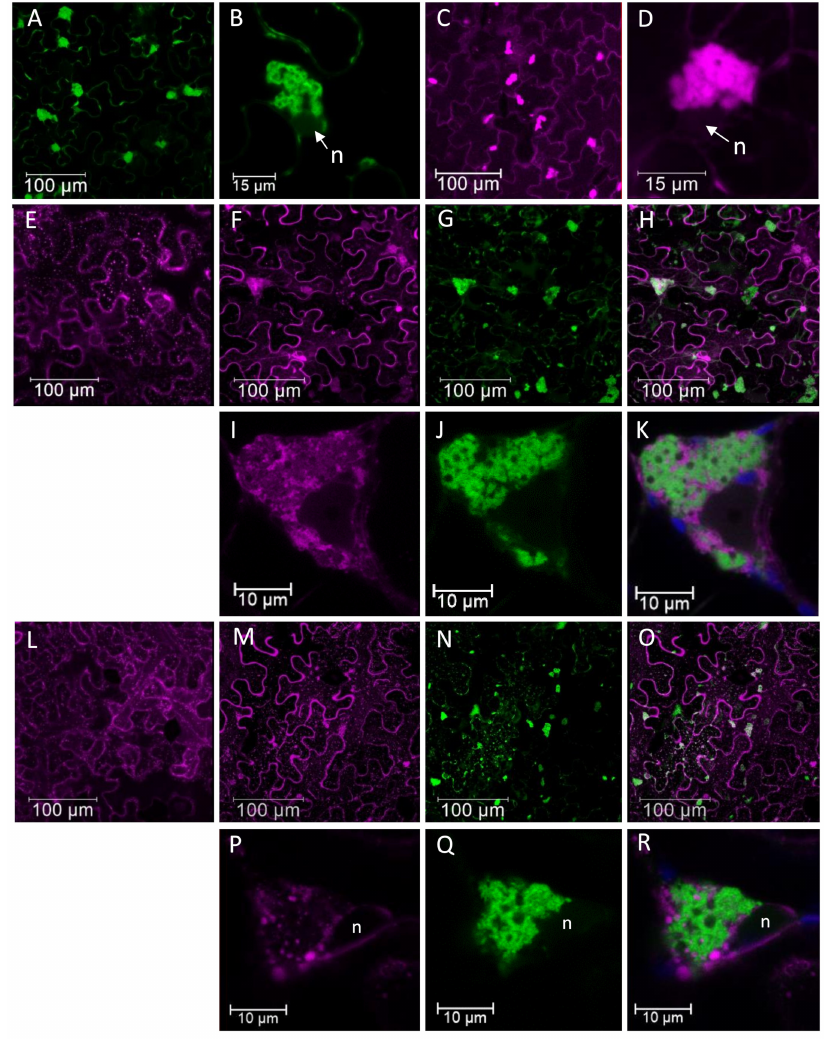
Figure 6. Pepino mosaic virus (PepMV)-induced subcellular bodies in Nicotiana benthamiana and tomato plants. ( A ) and ( B ) confocal laser scanning microscopy (CLSM) images of PepGFPm2 infection in N. benthamiana at 3 days post-inoculation (dpi). ( B ) High magnification of a fluorescent body in PepGFPm2 infection to show its cytoplasmic localization and spatial relation with the nucleus. ( C ) and ( D ) CLSM images of PepDsRed infection in tomato at 3 dpi. ( D ) High magnification image of a fluorescent body in PepDsRed infection. ( E ) Distribution of the endoplasmic reticulum marker (ER- mCherry) at 3 dpi in N. benthamiana epidermal cells in the absence of PepMV infection. In the presence of PepGFPm2 infection: ( F ) changes of ER-mCherry localization were observed, ( G ) green fluorescent bodies of PepGFPm2 and ( H ) merged image of ( F ) and ( G ) to see the matching. High magnification images: ( I ) the distribution of ER-mCherry during the infection, ( J ) the PepMV subcellular body and ( K ) merging of ( I ) and ( J ) to show the incomplete matching between the red and the green labelling in the body. ( L ) Distribution of Golgi-mCherry marker at 3 dpi in N. benthamiana epidermal cells in the absence of PepMV infection. In the presence of PepGFPm2 infection: ( M ) changes of Golgi-mCherry localization were observed ( N ), green fluorescent bodies of PepGFPm2 and ( O ) merged image of ( M ) and ( N ) to show the matching. High magnification images: ( P ) the distribution of Golgi-mCherry during the infection, ( Q ) the PepMV subcellular body, and ( R ) merged image of ( P ) and ( Q ) to show the incomplete matching between the red and the green labelling in the body. Notes: n, nucleus. Blue color corresponds to chloroplasts autofluorescence. Scale bars are displayed with the images. This figure is adapted with permission from